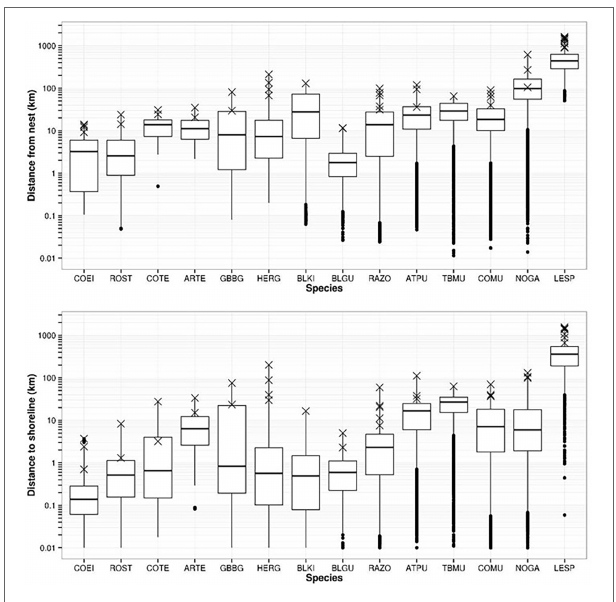
FIGURE 3 | Distribution of tracking data for 14 seabird species (codes in Table 1 caption) with respect to distance from colony sites (upper panel) and distance to coastline (lower panel). Boxplots show median distance, 1 st and 3 rd quantiles, 95% confidence intervals (whiskers), and outliers (dots). Data are pooled among sites for each species, but “X” represents maximum foraging ranges for each tracked colony (taken from Table 4